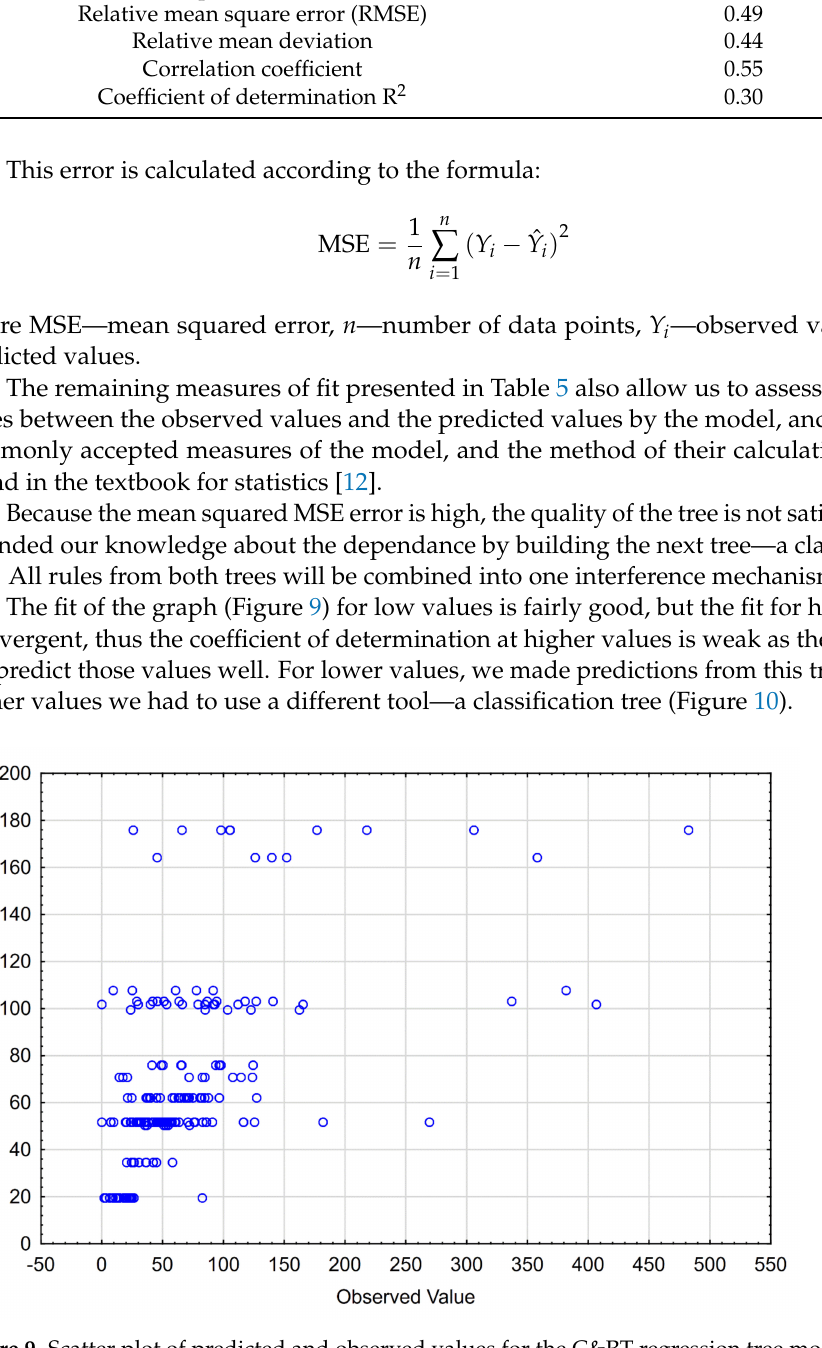
Figure 9. Scatter plot of predicted and observed values for the C&RT regression tree